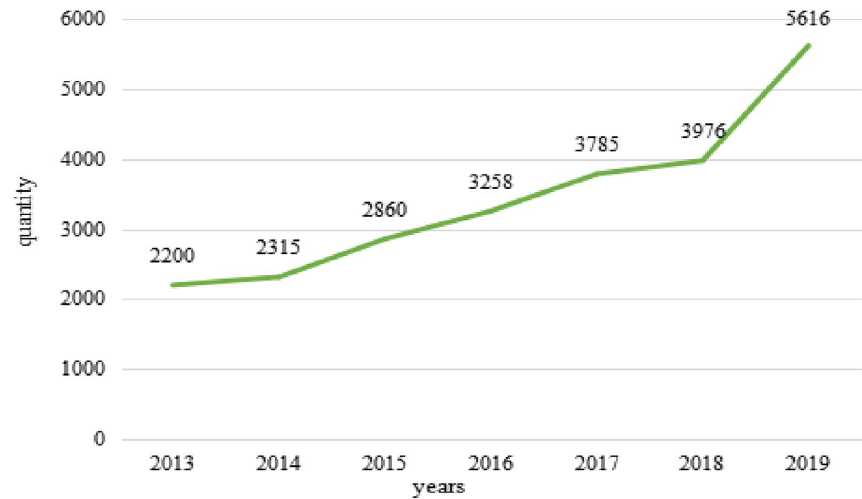
Fig. 11 Trend chart of the added value of China’s sports industry from 2013 to 2019